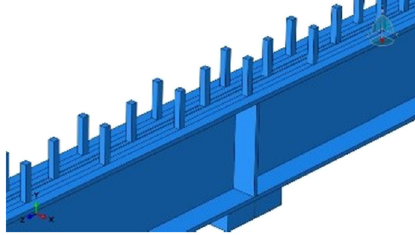
Figure 5: Shear connectors distribution for Group C.